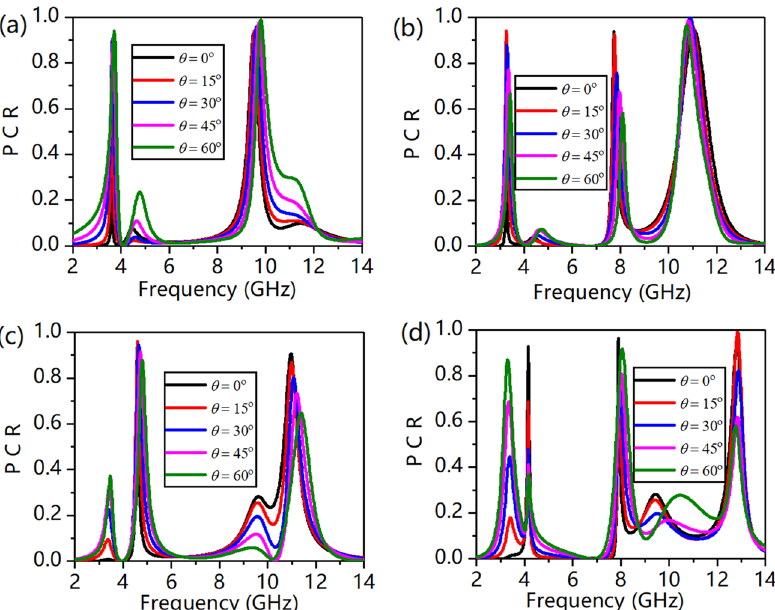
Figure 7. ( a ) PCR of reflection under x-polarization, ( b ) PCR of transmission under x-polarization, ( c ) PCR of reflection under y-polarization, and ( d ) PCR of transmission wave under y-polarization.